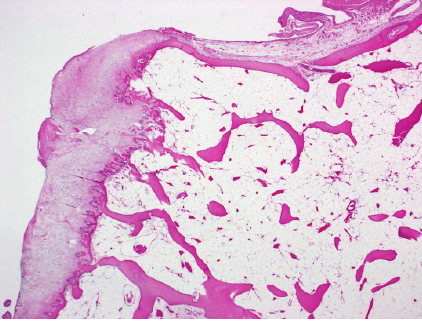
Figure 6: Histopathology of resected tumor showing cartilaginous tissue with calcification (hematoxylin and eosin stain ×